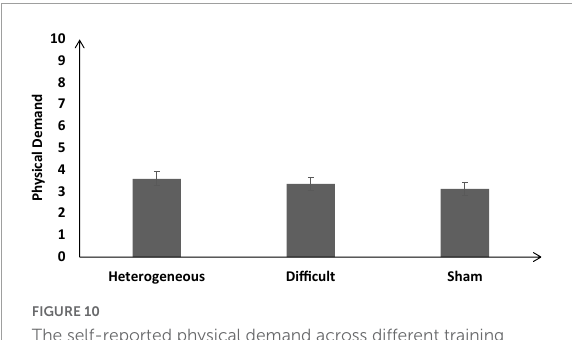
FIGURE10 The self-reported physical demand across different training conditions. The error bars show 95% CI around point